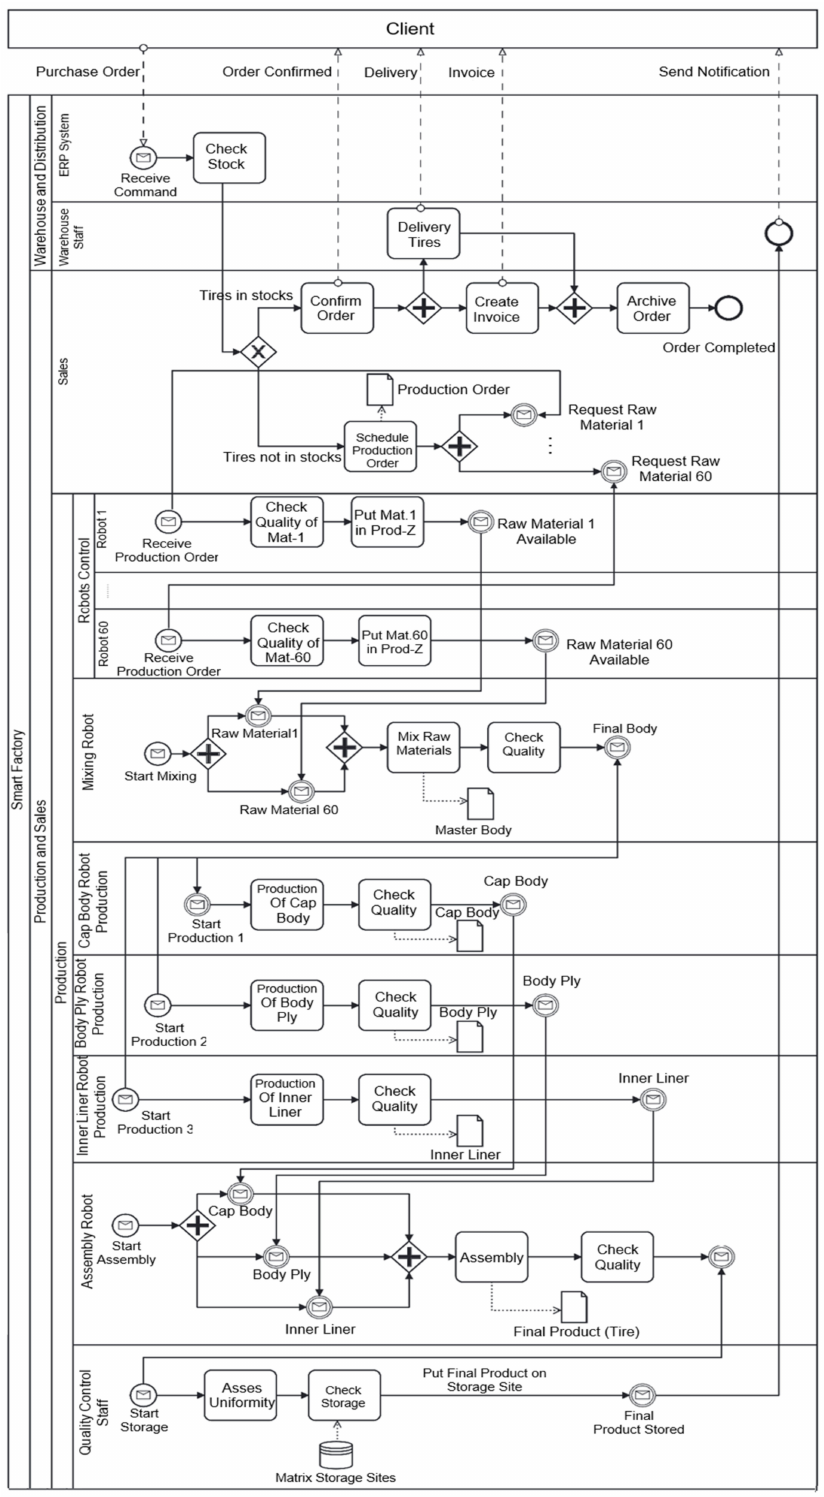
Figure 2. Proposed IoT Cloud-based ERP production business process for